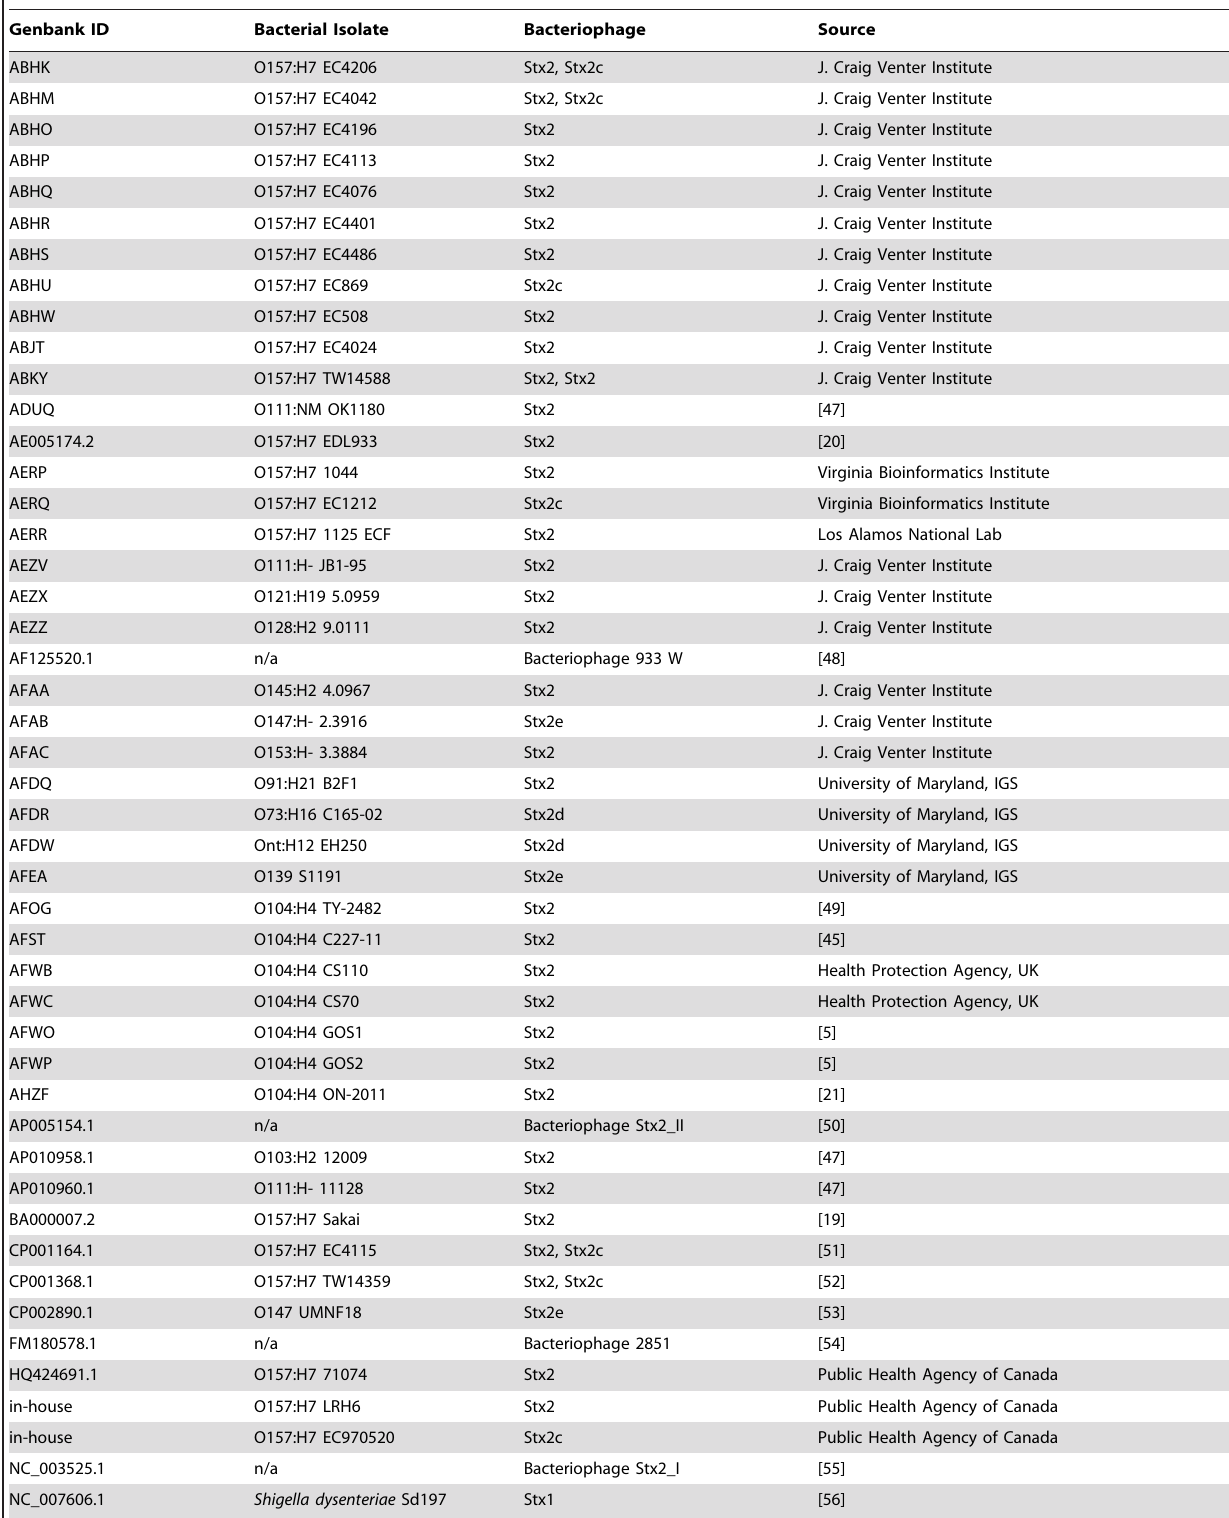
Table 1. The Stx2-bacteriophage and genomic sequences used in the current